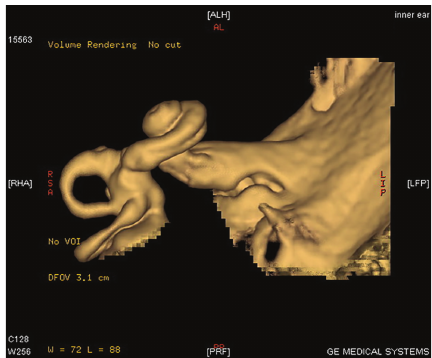
Figure 3: MRI scan with 3D reconstruction of inner ear showing cochlear anomaly in which cochlea shows 1 and 1 / 2 turns.